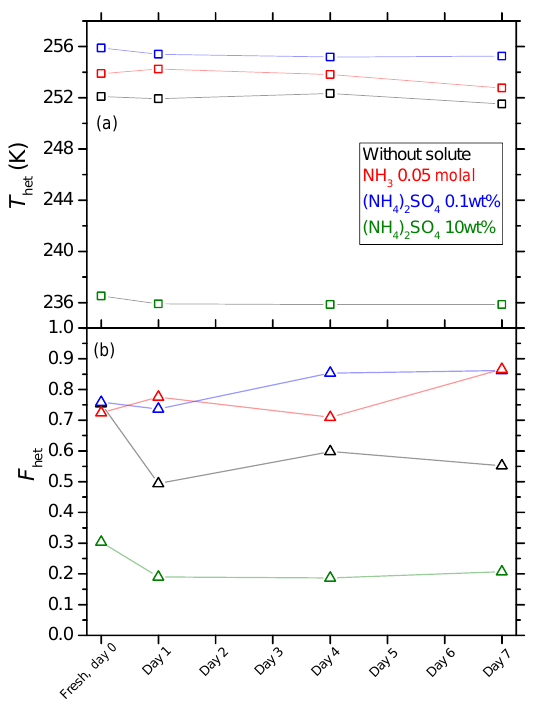
Figure 7. Development of T het ( a – squares) and F het ( b – triangles) for 2wt% microcline suspended in water, 10wt% ( NH 4 ) 2 SO 4 , 0.1wt% ( NH 4 ) 2 SO 4 and 0.05 molal ammonia solutions over a pe- riod of 1